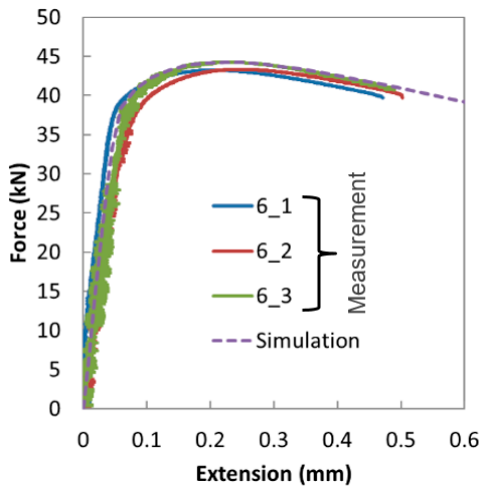
Figure 18. Comparison of forces for notched tensile test.